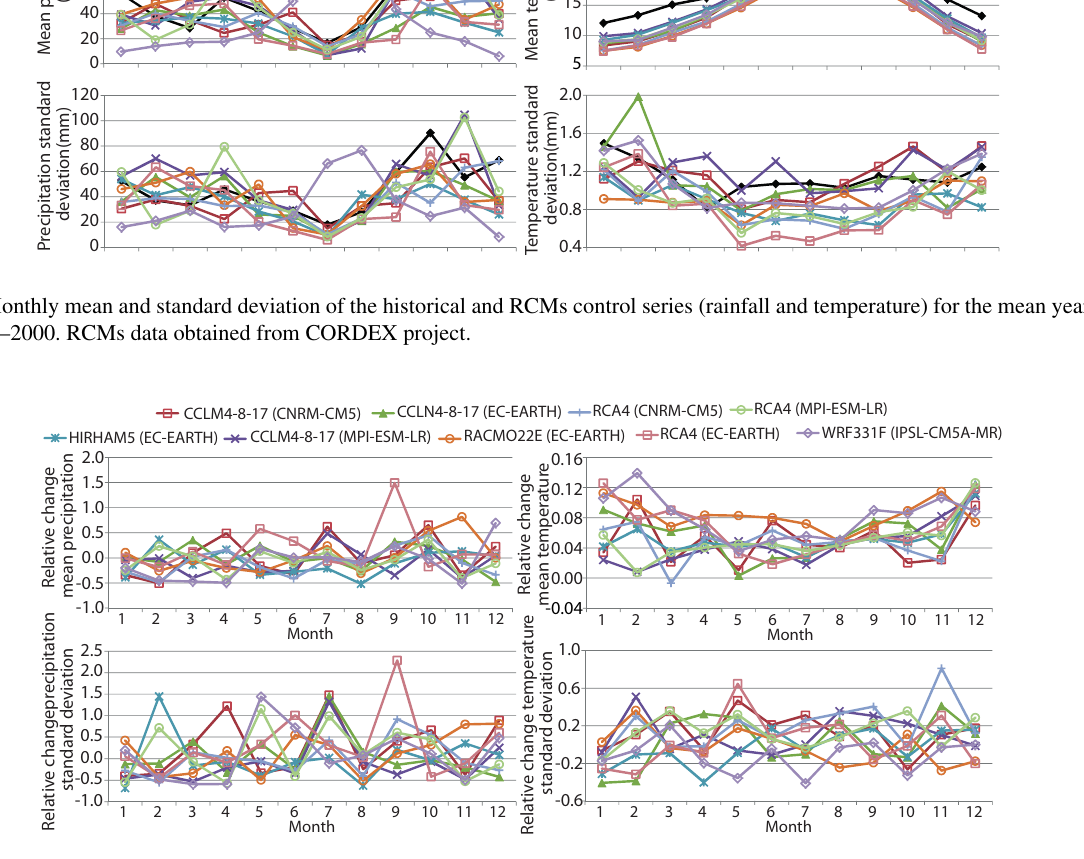
Figure 7. Relative monthly change in mean and standard deviation of the future series (2011–2035) with respect to the control series (1976– 2000) for the considered RCMs under the RCP8.5 emission